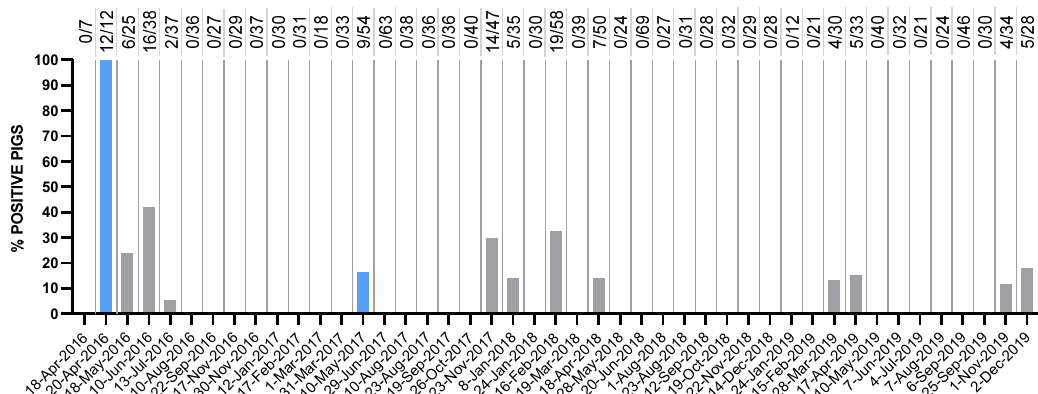
Figure 1. Percentage of atypical porcine pestivirus (APPV)-positive pigs detected during monthly screening in the farm by RT-qPCR analysis. The x -axis shows the sampling date from April 2016 to December 2019. The percentage of positive samples is shown in the y -axis. Blue-colored columns show that positive PCR results were accompanied by clinical CT symptoms on those specific months—i.e., April 2016 and May 2017. The number of PCR-positive animals in relation to the total number tested each specific month is shown above the columns.